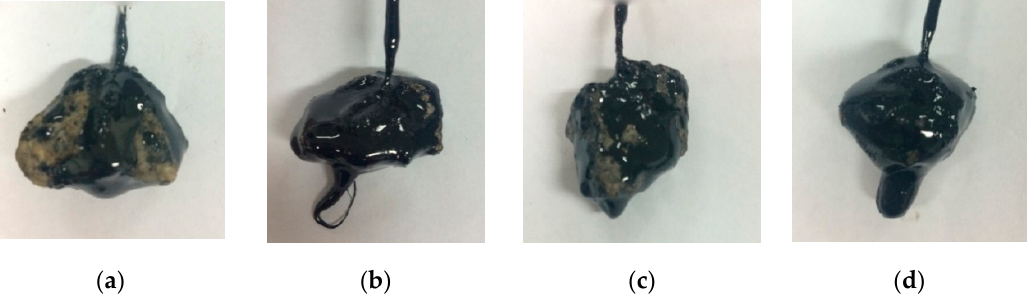
Figure 5. Visual observation of granite aggregates after stripping test: ( a ) #90 asphalt (control); ( b ) #90 asphalt (treated); ( c ) #110 asphalt (control); and ( d ) #110 asphalt